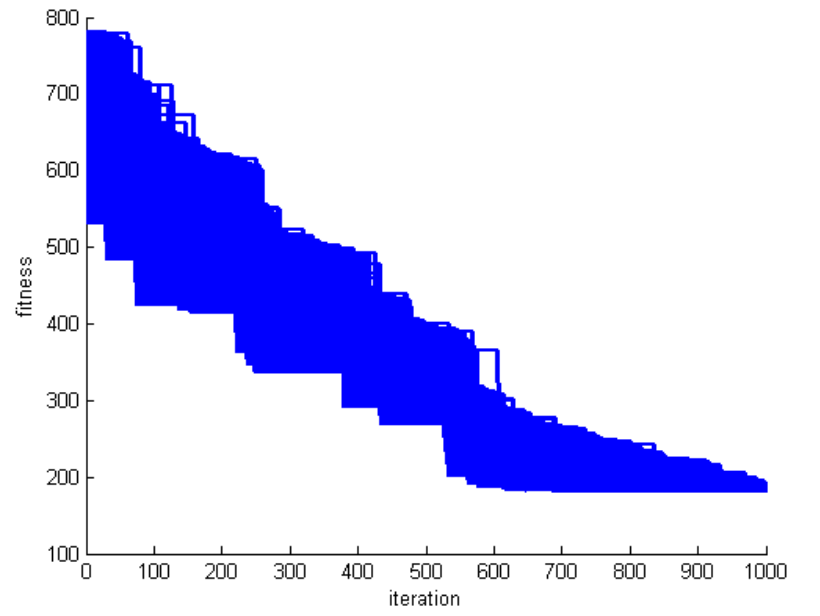
Figure 8. Whale fitness during motion in DS 1